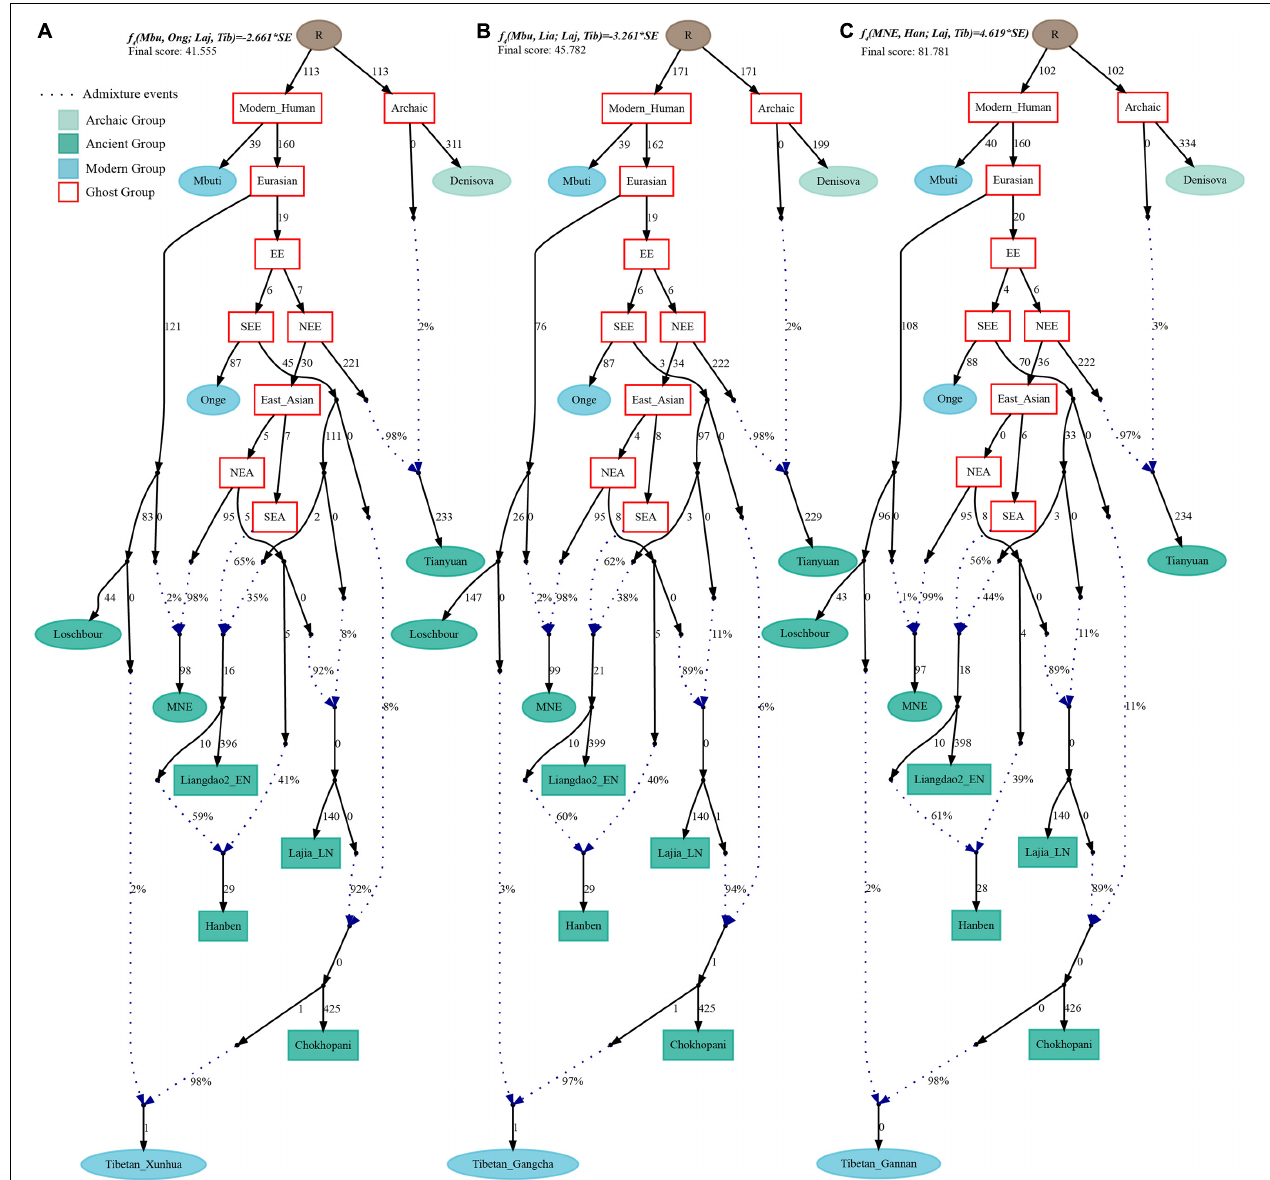
FIGURE 7 | Admixture graph model of East Asians and modern Tibetans from the northeast Tibetan Plateau based on the Human Origin dataset. Admixture history of Tibetan from Xunhua (A) , Tibetan from Gangcha (B) , and Tibetan from Gannan (C)